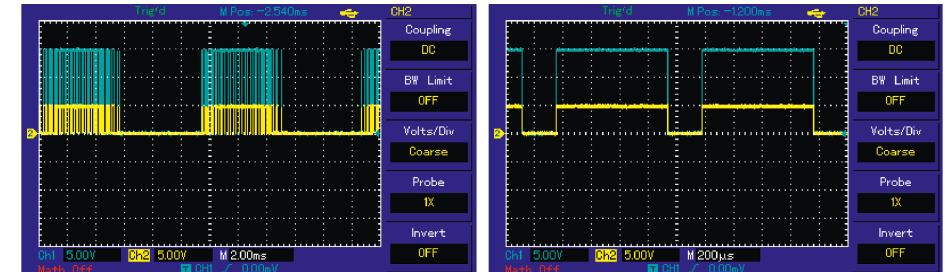
Figure 13: The generated waves and GS wave signals at different frequencies.